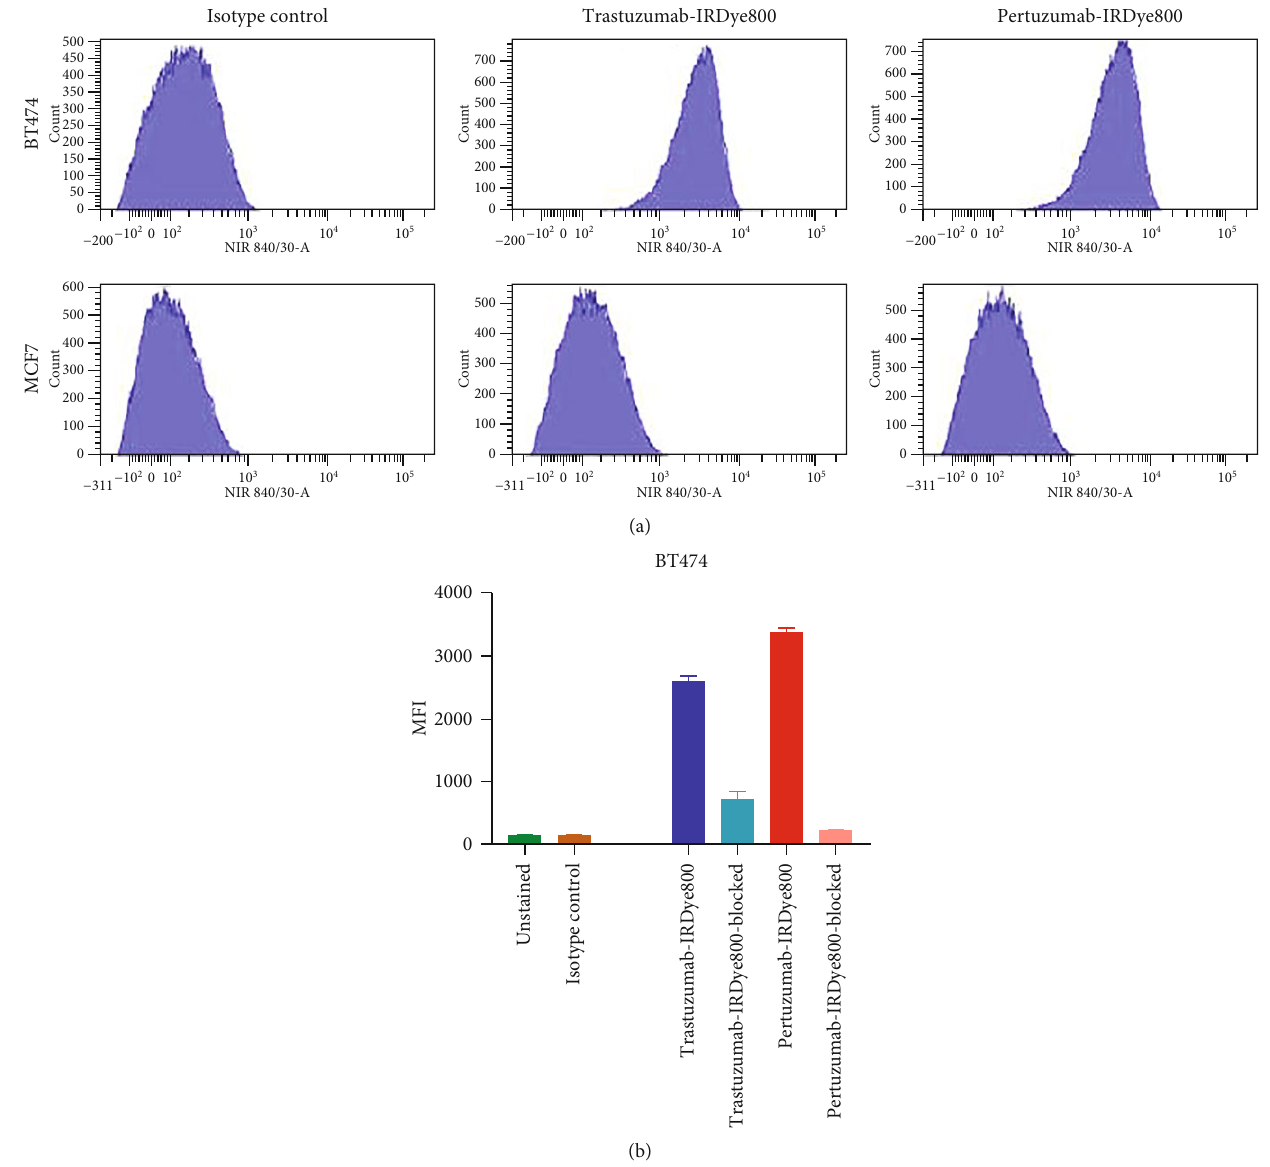
Figure 1: Flow cytometry analysis of IRDye800-immunocojugate binding in HER2-postive (BT474) and HER2-negative (MCF7) cells. HER2-speci fi c binding was observed for trastuzumab-IRDye800 and pertuzumab-IRDye800 as indicated by a shift of the fl uorescence signal to the right in BT474 cells compared to the lower fl uorescence values measured from MCF7 cells (a). Plot of the MFI values of BT474 cells incubated with the immuoconjugates and the blocking doses of the unconjugated parental antibodies